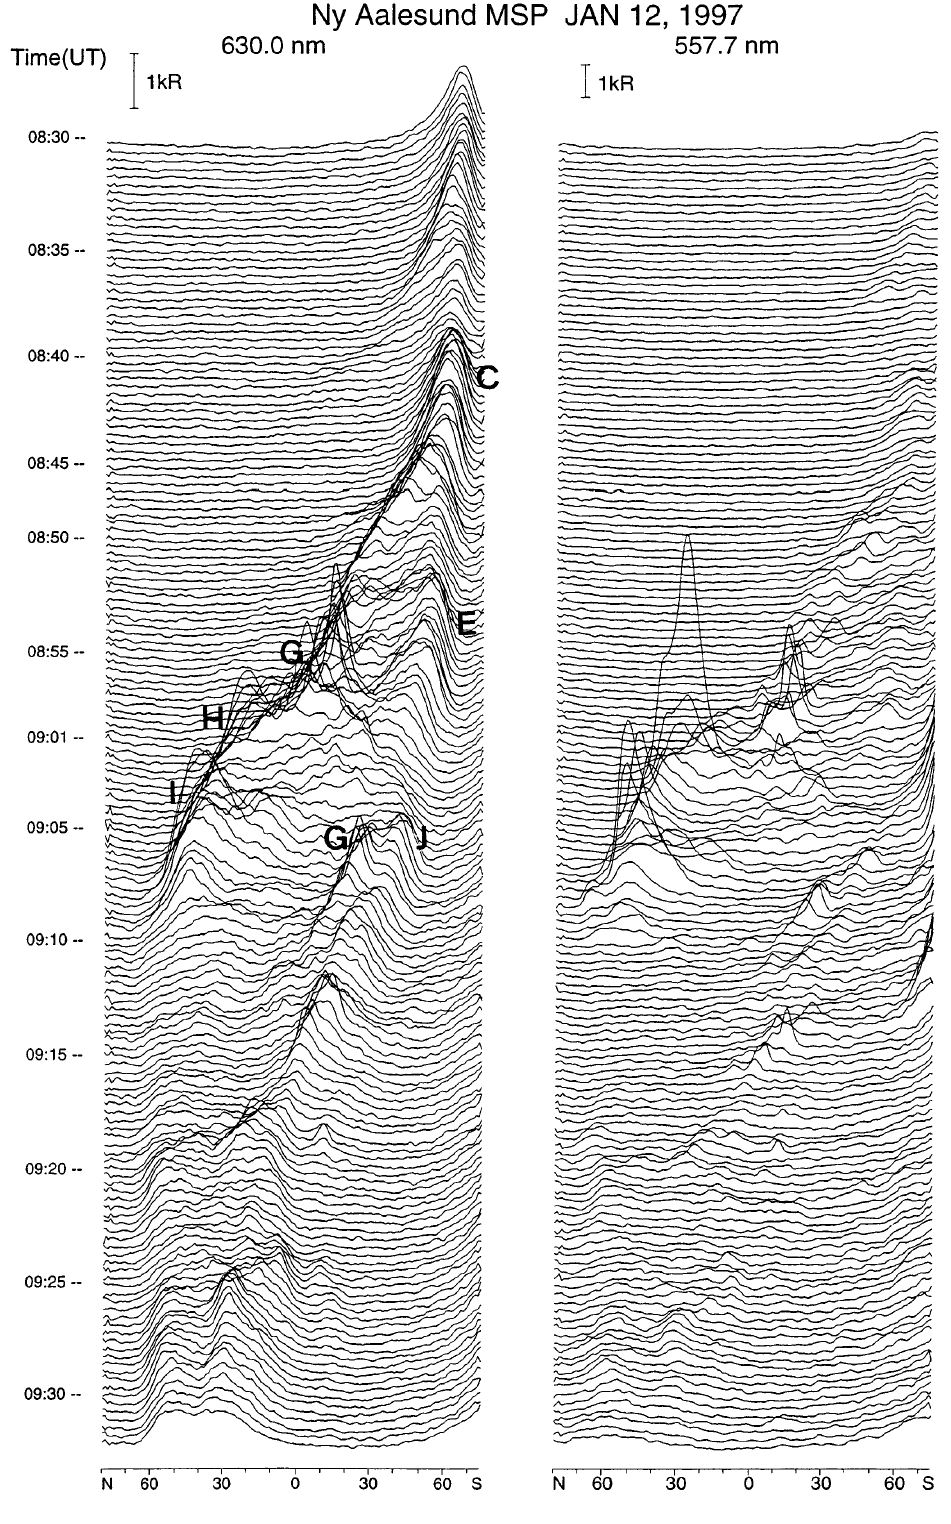
Fig. 5. Scans by the meridian- scanning photometers at Ny A˚ lesund, Svalbard on 12 January 1997. 630 nm ( left ) and 557.7 nm ( right ) intensity is shown as a function of time (increasing down the page) and zenith angle according to the scale bars given at the top of each column. The zenith angles vary between 80 (cid:176) to the north of Ny A˚ lesund and 70 (cid:176) to the south. The latitude of the emis- sions depends on the emission profile with altitude (see Lock- wood et al. , 1993). Auroral forms seen by the 630 nm all-sky camera, are marked for the on left panel if and when they appear in the merdian scanned by the photometer, using the same lettering code as Fig.